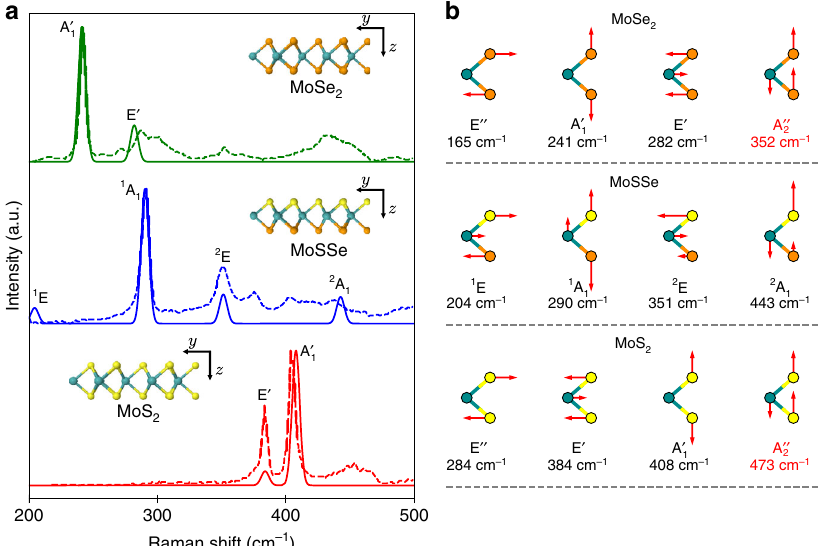
Fig. 3 Evolution of Raman spectra from MoSe 2 over MoSSe to MoS 2 . a Comparison of the computed Raman spectra (solid) with the experimental results in ref. 36 (dashed) for MoSe 2 (top), MoSSe (middle) and MoS 2 (bottom). The excitation wavelength is 532 nm, and both input and output electromagnetic fi elds are polarized along the y -direction. b Optical phonon modes for MoSe 2 (top), MoSSe (middle) and MoS 2 (bottom) labeled by the irreducible representations of the respective point groups. Note that A 00 modes (shown in red) are Raman 2